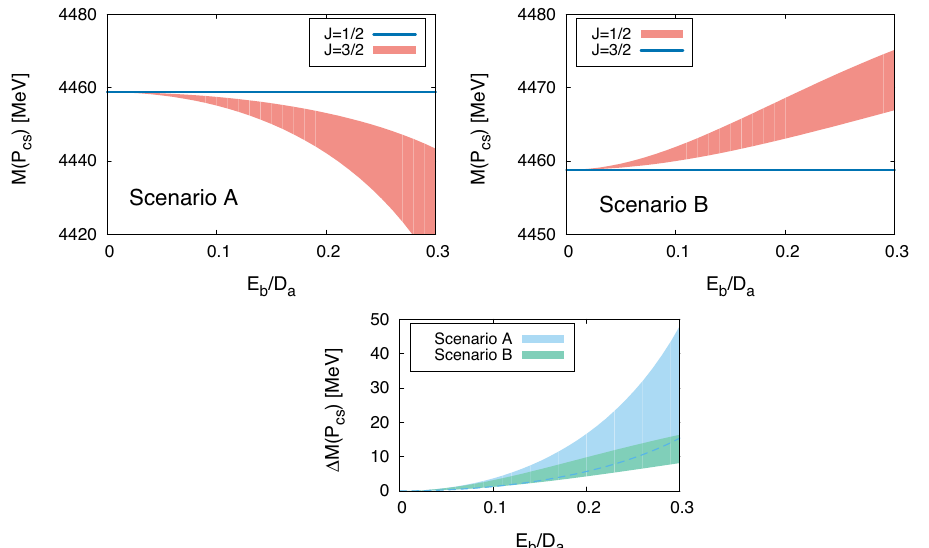
and 3 molecular 2 2